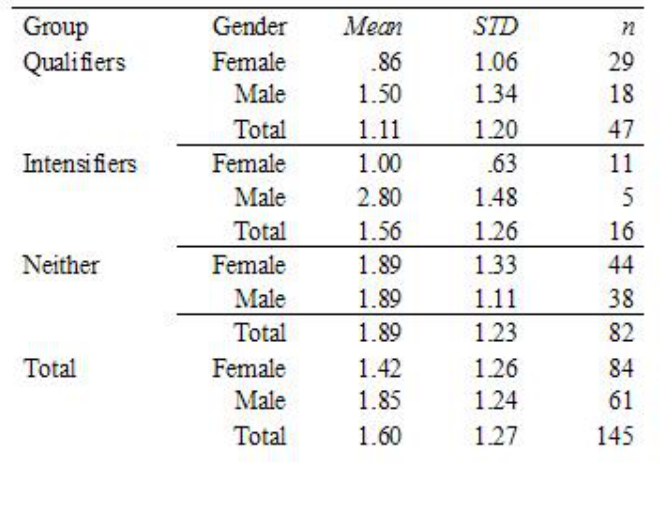
Note: Based on messages posted by 22 females and 10